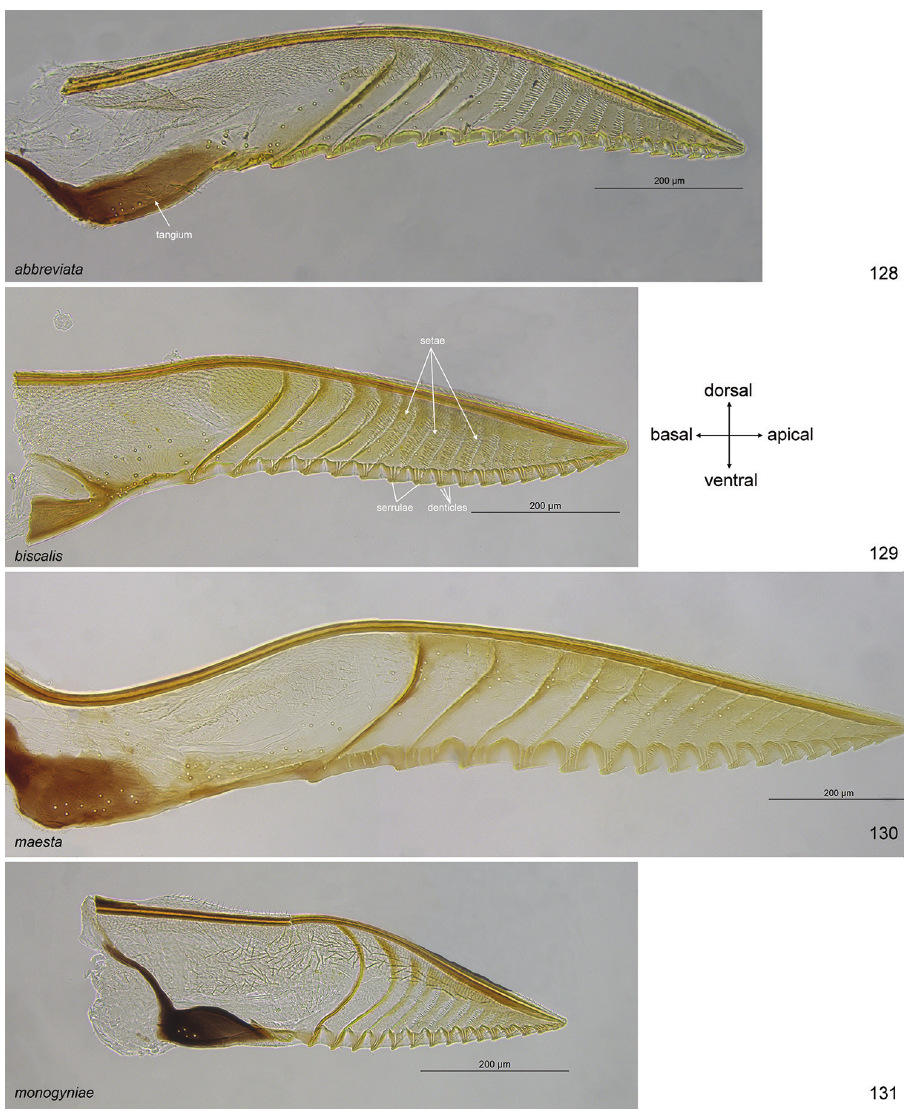
Figures 128–131. Lancets of Pristiphora . 128 abbreviata DEI-GISHym17687 129 biscalis DEI- GISHym20953 130 maesta PR.578VV_506 131 monogyniae